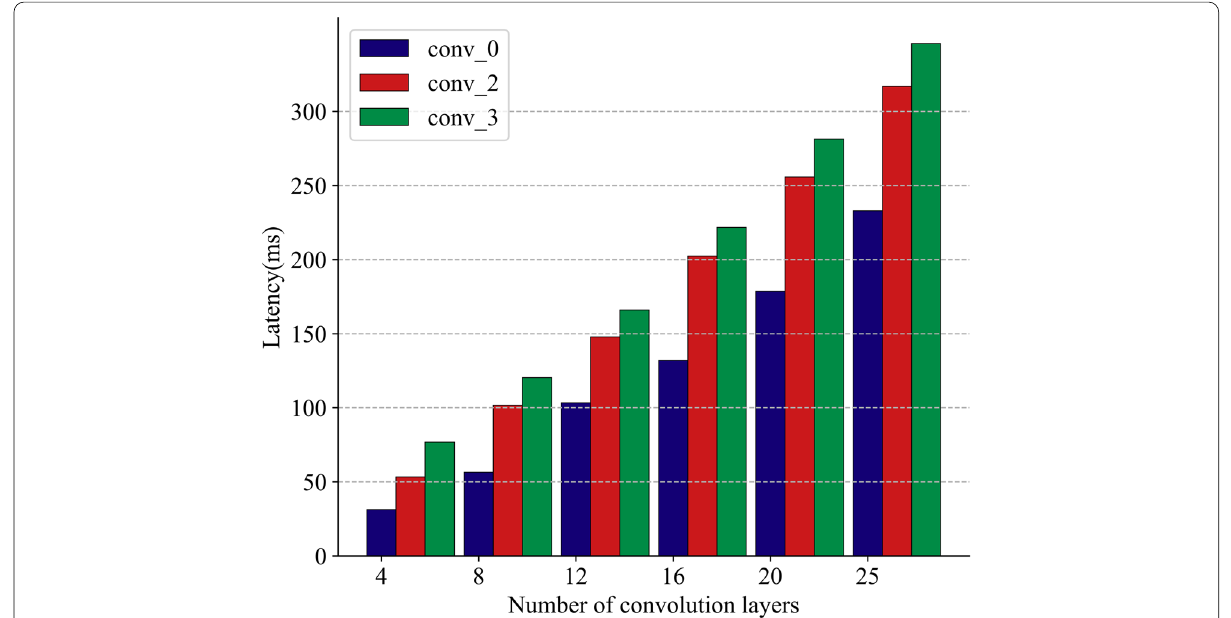
Fig. 2 Comparison of inference delay between residual structure and straight